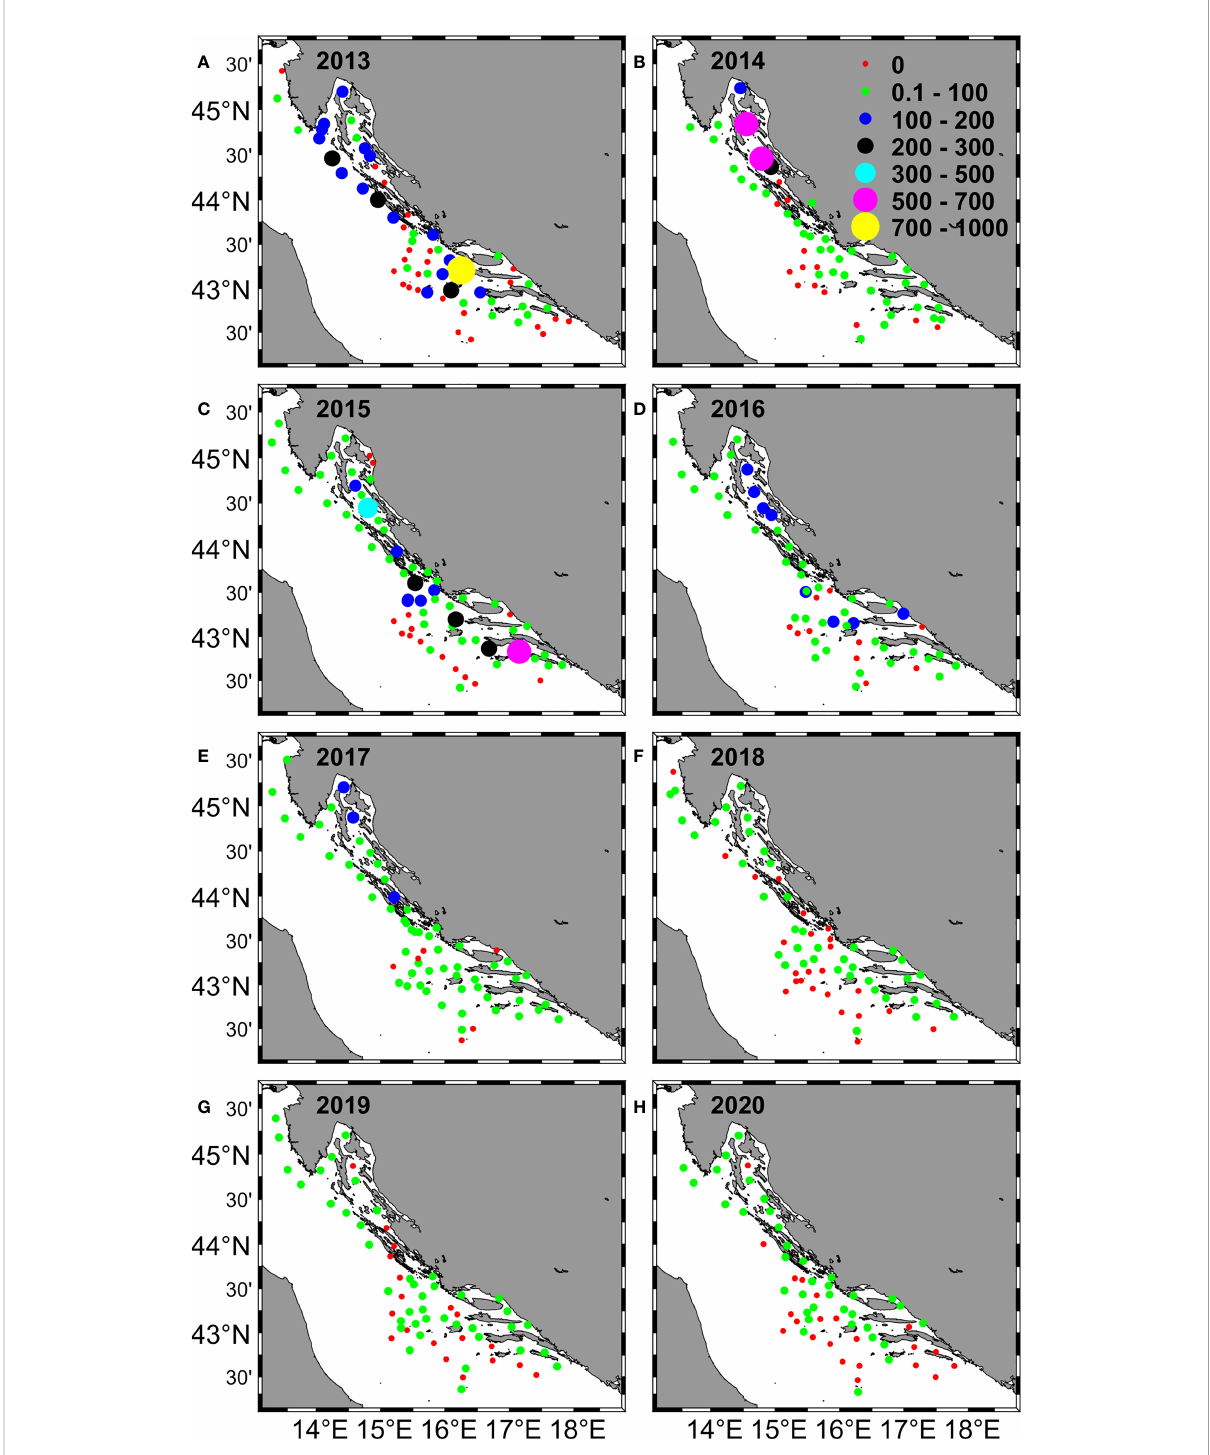
FIGURE 3 Distribution of Adriatic anchovy larvae collected in the eastern Adriatic Sea during the summer surveys from 2013 - 2020 (A – H) . The abundance of larvae (larvae/m 2 ) is represented by different circle sizes and